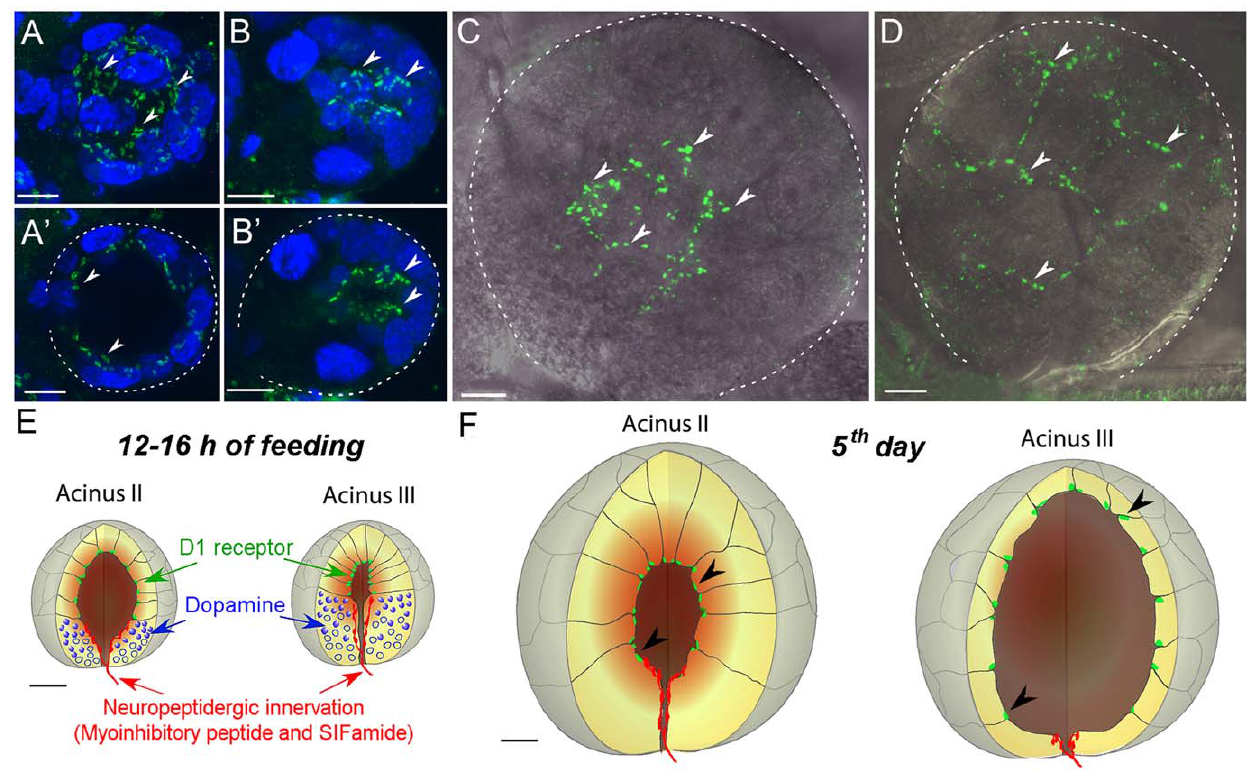
Figure 5. Immunohistochemistry for D1 receptor in the salivary glands. (A) Whole acinus II of unfed female shown as a 27 m m-thick composite image or (A’) a selected thin optical layer for a 10 m m thick demonstrating the apical location of the D1 receptor immunoreactivities. (B) Whole acinus III of an unfed female shown as a composite image of 34 m m thickness or (B’) a selected thin optical layer for a 5 m m thick demonstrating the apical location of the D1 receptor immunoreactivities. (C) Acini II and (D) III of a female at the 5th day post-attachment. Ten- micrometer-thick confocal composite images overlaid with the differential interference contrast images are shown. Schematic diagram showing the D1 (green), dopamine (blue), and neuropeptidergic innervation (red) [13] in acini II and acini III of the 12–16 hour fed female (E) and 5th day post- attachment in a female (F). Arrowheads indicate the scattered patches of D1 receptor reaction on the luminal side of the acini. Doted lines in A’, B’, C, and D indicate the boundary of an acinus. Blue in A to B’ is nuclei stained with DAPI. Scale bars are equally for 10 m m.